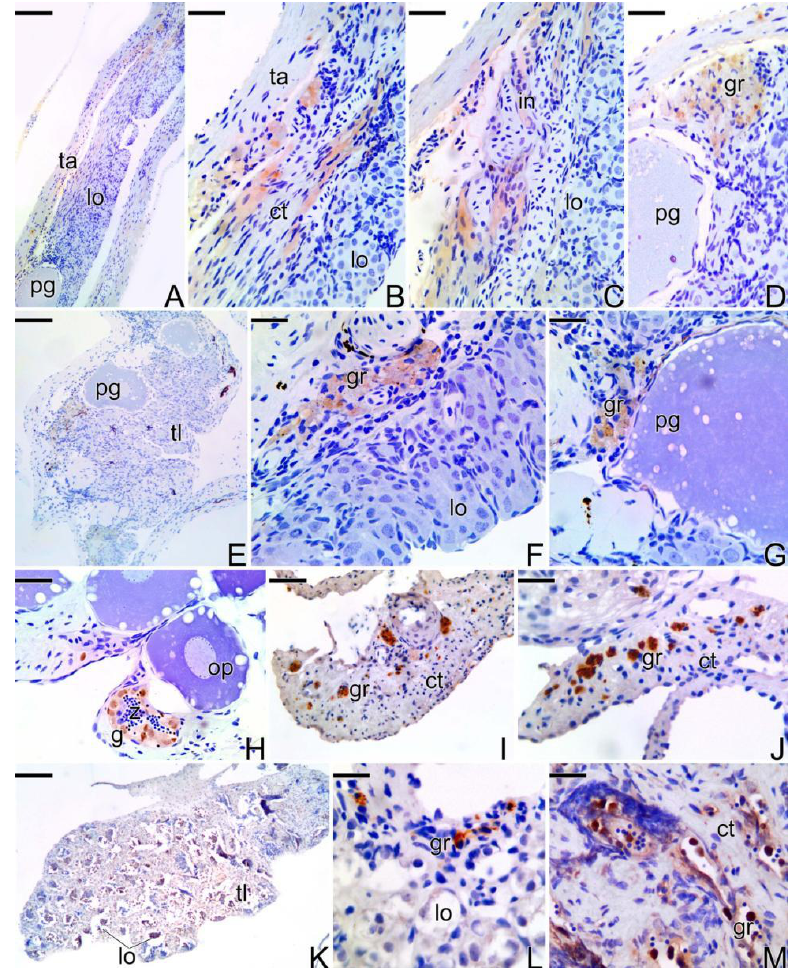
Figure 11. Immunohistochemistry for detection of MMP-9 ( A – D , J ), MMP-2 ( E , F , I , K – M ), and MMP-14 ( G ) metalloproteinases in testis of secondary males of S. marmoratus . Note the decline in the expression of the MMPs according to the end of the sex reversal process. Tunica albuginea (ta), testicular lobules (lo), connective tissue (ct), interstitium (in), primary growth oocyte (pg), granulocytes (gr), spermatogonia (g), testicular lamellae (tl), spermatozoa (z). Counterstaining: Harrys Hematoxylin. Bar: 80µm ( A , E ), 40µm ( B , C , I ), 30µm ( D , F , G ), 20µm ( H , J , L , M ). In testes of the primary males, MMP-2 and MMP-9 (Figure 12C) were detected in the spermatogonia that constitute the germinal epithelium of the testicular lobules. The same positive result was observed for MMP-14 (Figure 12D,E). After the beginning of the spermatogenesis, none of the enzymes was detected, not even in granulocytes or in melanomacrophage centers (Figure 12F,G). The expression of the metalloproteinases (MMP-2, MMP-9 and MMP-14) was also confirmed by the negative control sections of the Synbranchus marmoratus treated with TBS instead of primary antibody (Supplementary S2) and by the positive control in sections of ovaries from mouse specimens (Supplementary S3).